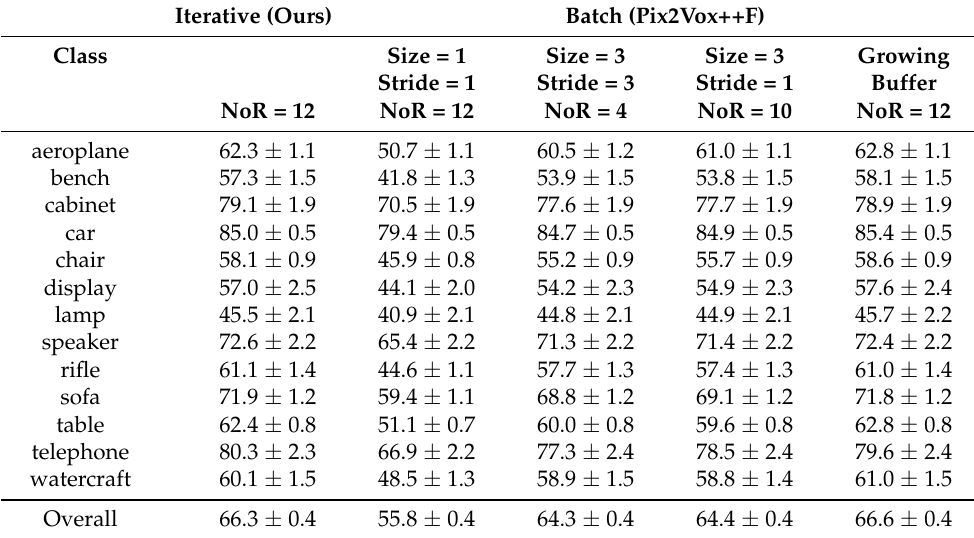
Table 4. Comparison of the average IoU over time obtained by each processing strategy on 12 selected viewpoints in the R2N2 dataset. The results show that our iterative method outperforms all batching methods in an online environment when resources are limited. We also display the number of reconstructions (NoR) during the sequence for each processing method.